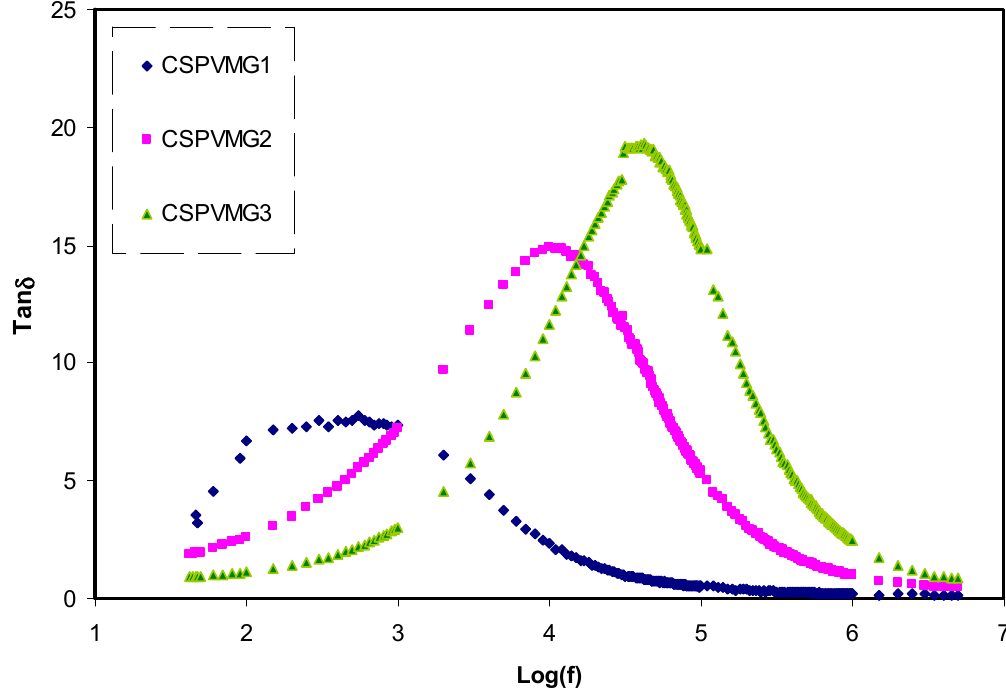
Figure 4. Variation of loss tangent (tan δ ) versus frequency for the CSPVMG1, CSPVMG2, and CSPVMG3 electrolyte samples at room temperature.